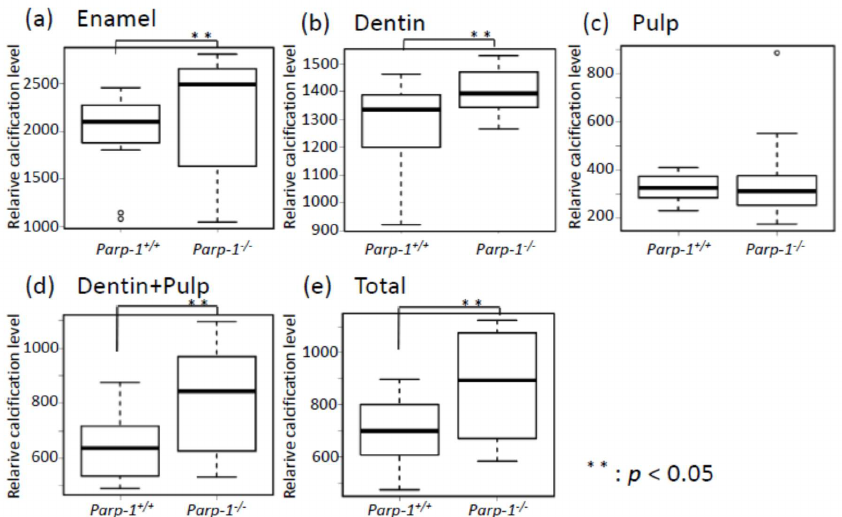
Figure 6. Relative evaluation of calcification levels of each element of tooth in aged Parp-1 +/+ and Parp-1 − / − incisors. ( a ) Comparison of relative calcification levels of enamel in Parp-1 +/+ and Parp-1 − / − , ( b ) dentin, ( c ) pulp, ( d ) dentin + pulp, and ( e ) total of the tooth. Air was set to be the zero reference. Parp-1 −/− incisors showed significantly higher calcification levels in enamel, dentin, dentin + pulp, and total of tooth. Six Parp-1 +/+ mice and ten Parp-1 −/− mice were used in this analysis. Cells 2019 , 8 , x